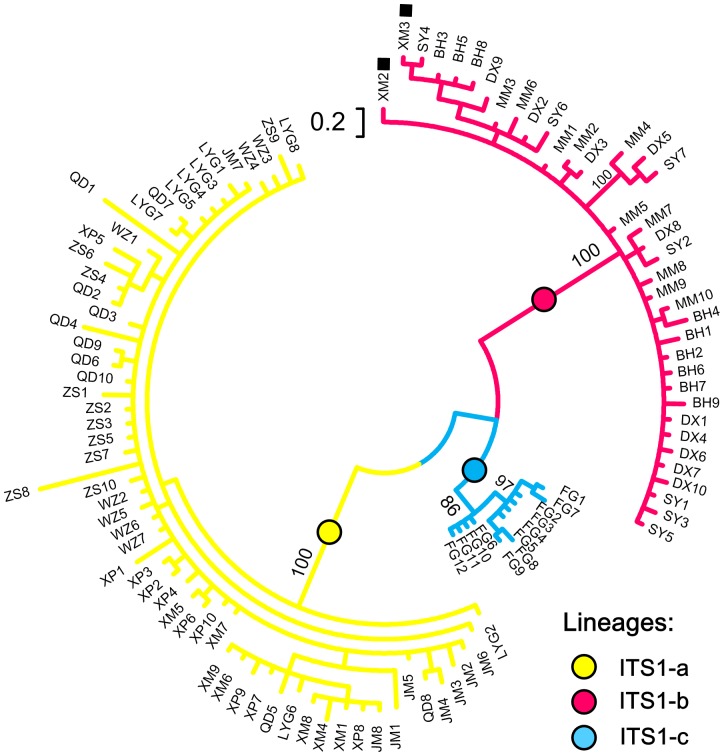
The Bayesian tree of ITS-1 haplotypes.Numbers above branches are Bayesian posterior probabilities for the main lineages. Support values less than 50% are not shown. Two individuals in Xiamen locality (site 16, ECS) observed in SCS lineage ITS1-b are indicated using black squares.